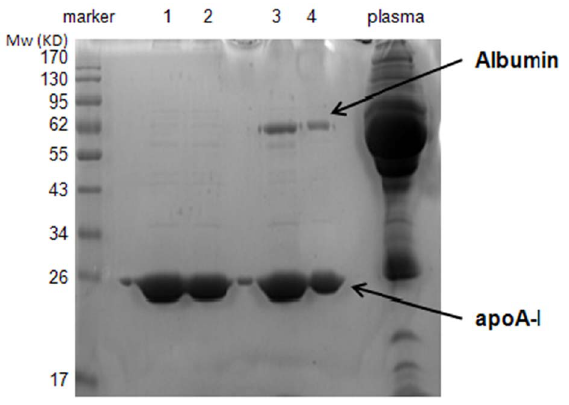
Figure 1. Analysis of HDL samples by SDS-PAGE (12%). Proteins were detected by staining with Coomassie blue (Invitrogen, the Netherlands). Lane 1 and 2 are representative of 25 m g high-abundance protein depleted HDL sample pools (from CHD group and